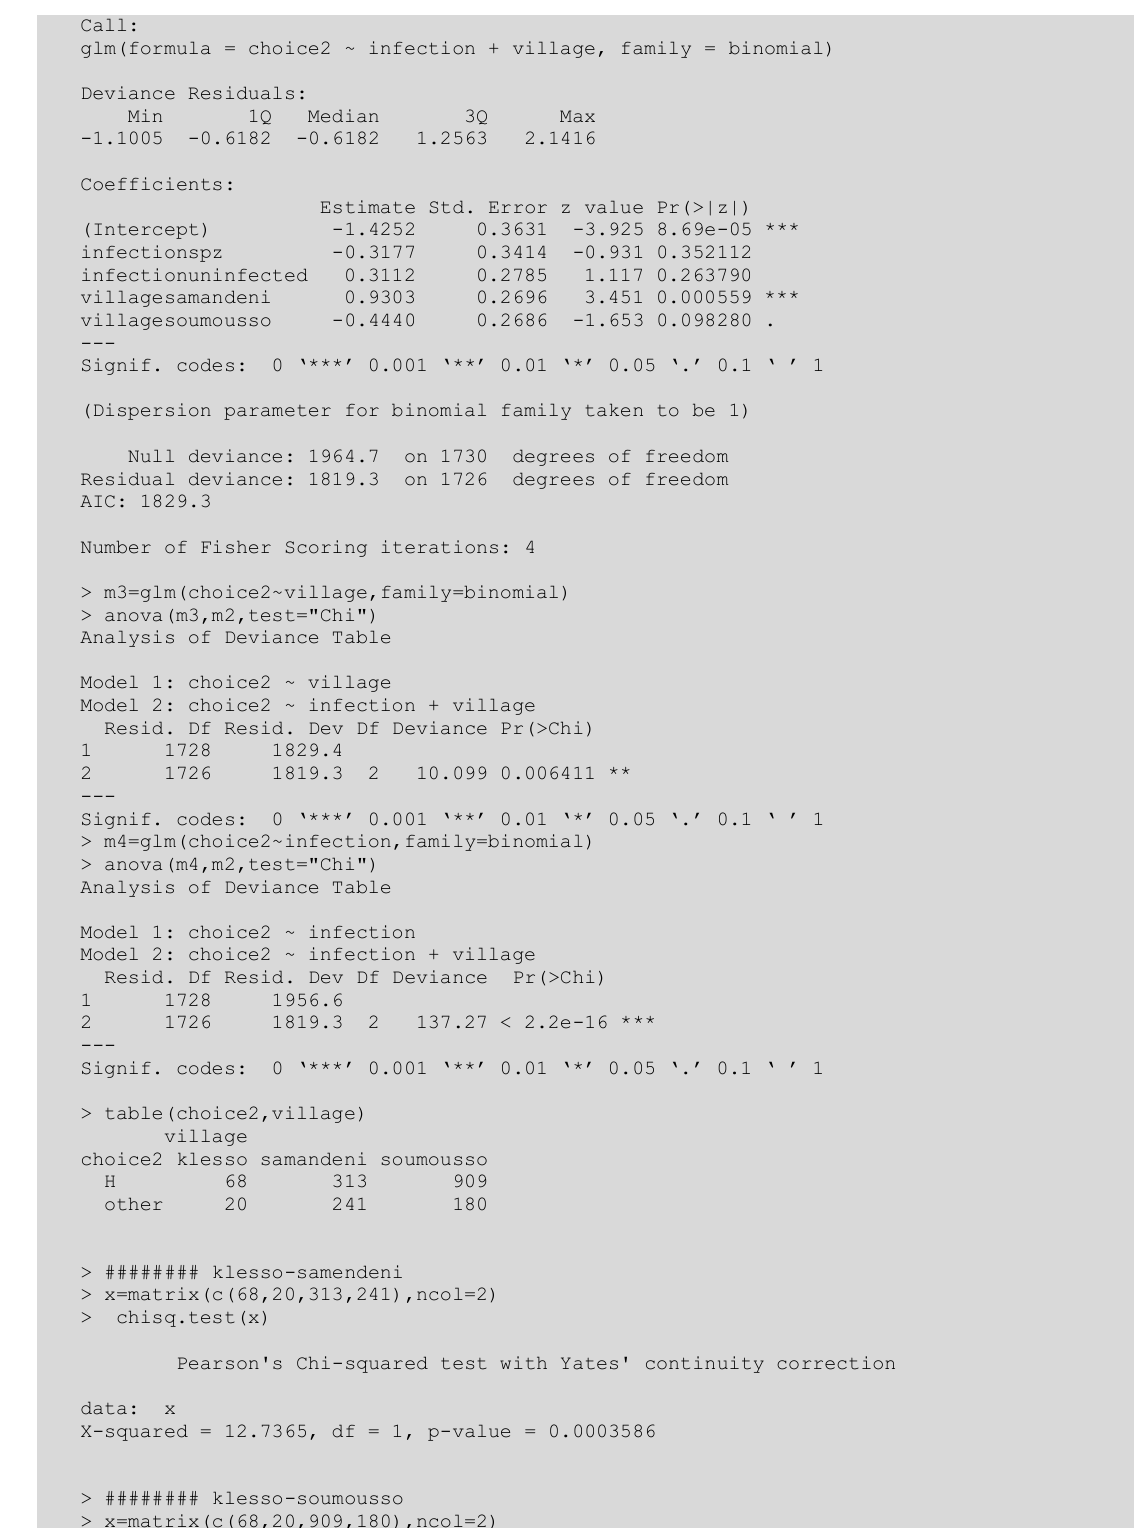
> table(choice2,village) village choice2 klesso samandeni soumousso